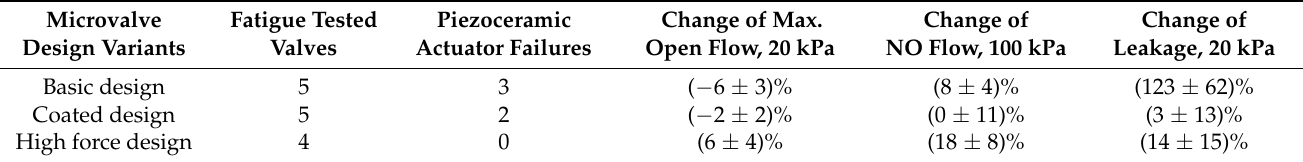
Table 3. Results of 1 × 10 6 actuation fatigue test. Listed as piezoceramic actuator failures are observed material failures of the PZT in form of cracks. Change in fluidic performance is given for valves with functional piezoceramic actuator. Microvalve Design